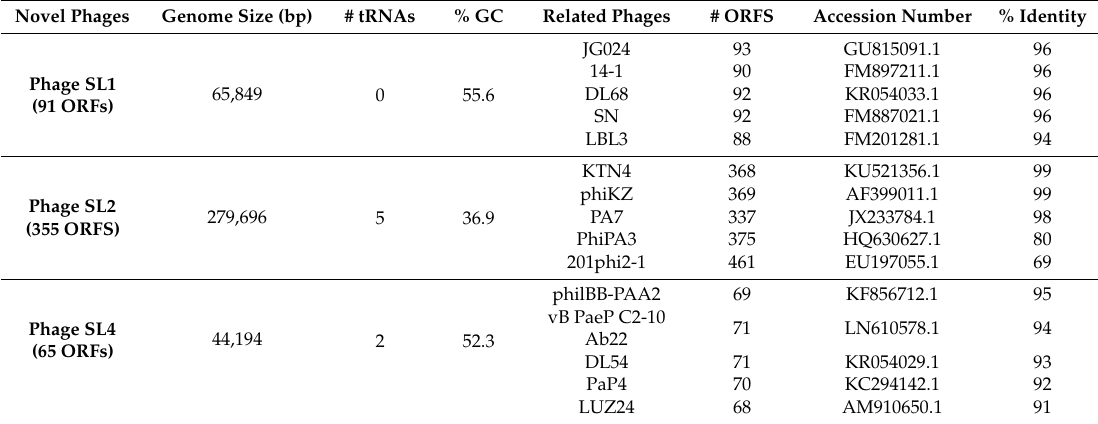
Table 1. Nucleotide sequence identity of phages SL1, SL2, and SL4 with known phages of the same genus. Novel Phages